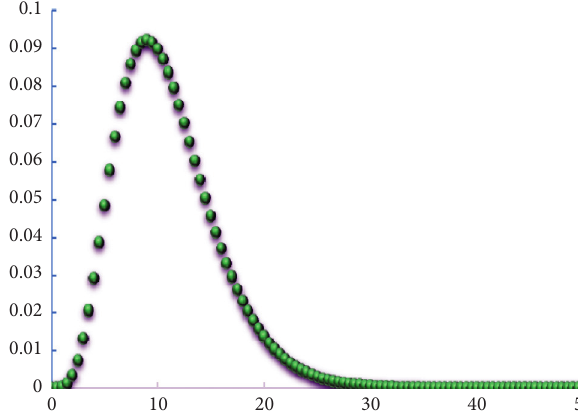
Figure 11: Probability density curve of chi square distribution not accumulating.